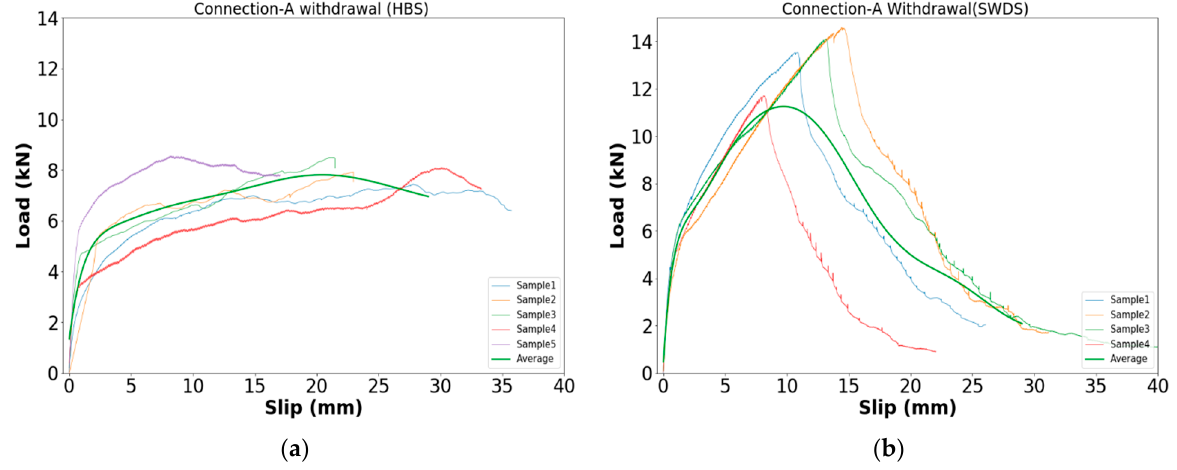
Figure 19. Load-slip curve of Connection-A in withdrawal: ( a ) HBS screw; ( b ) SDWS screw.